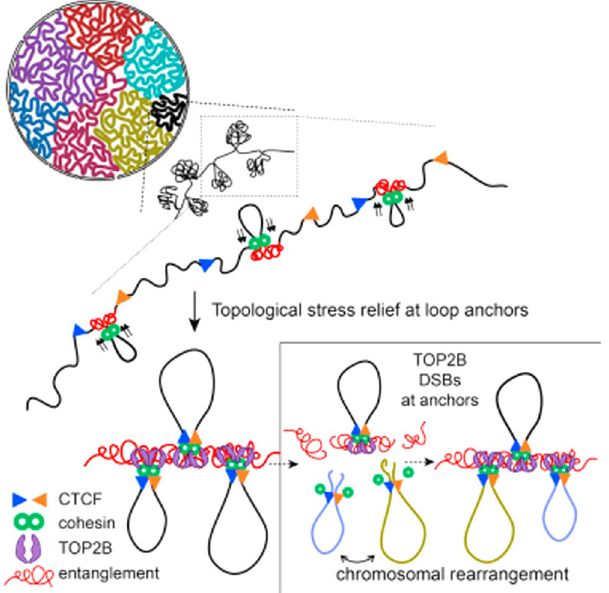
Figure 3. Organization of DNA forming topologically associating domain (TAD) within two CTCF sites in DNA sequence. (Retrieved from